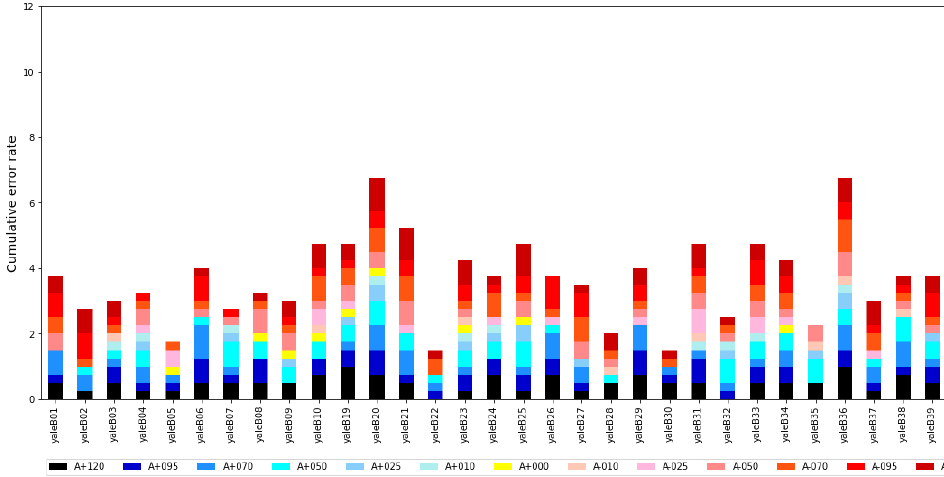
Figure 9. Comparison of the error rate of LBPH with different ambient light levels.